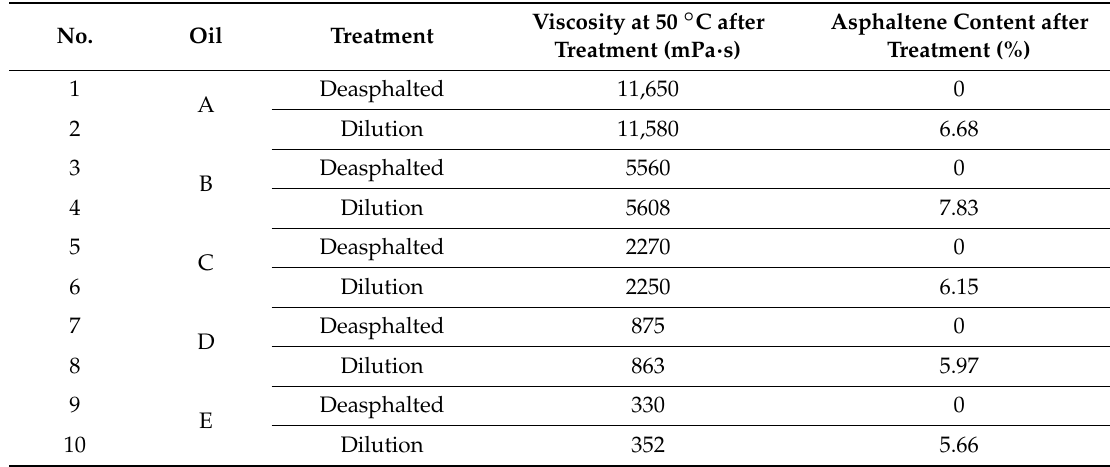
Table 2. Properties of the ten oil samples used in the